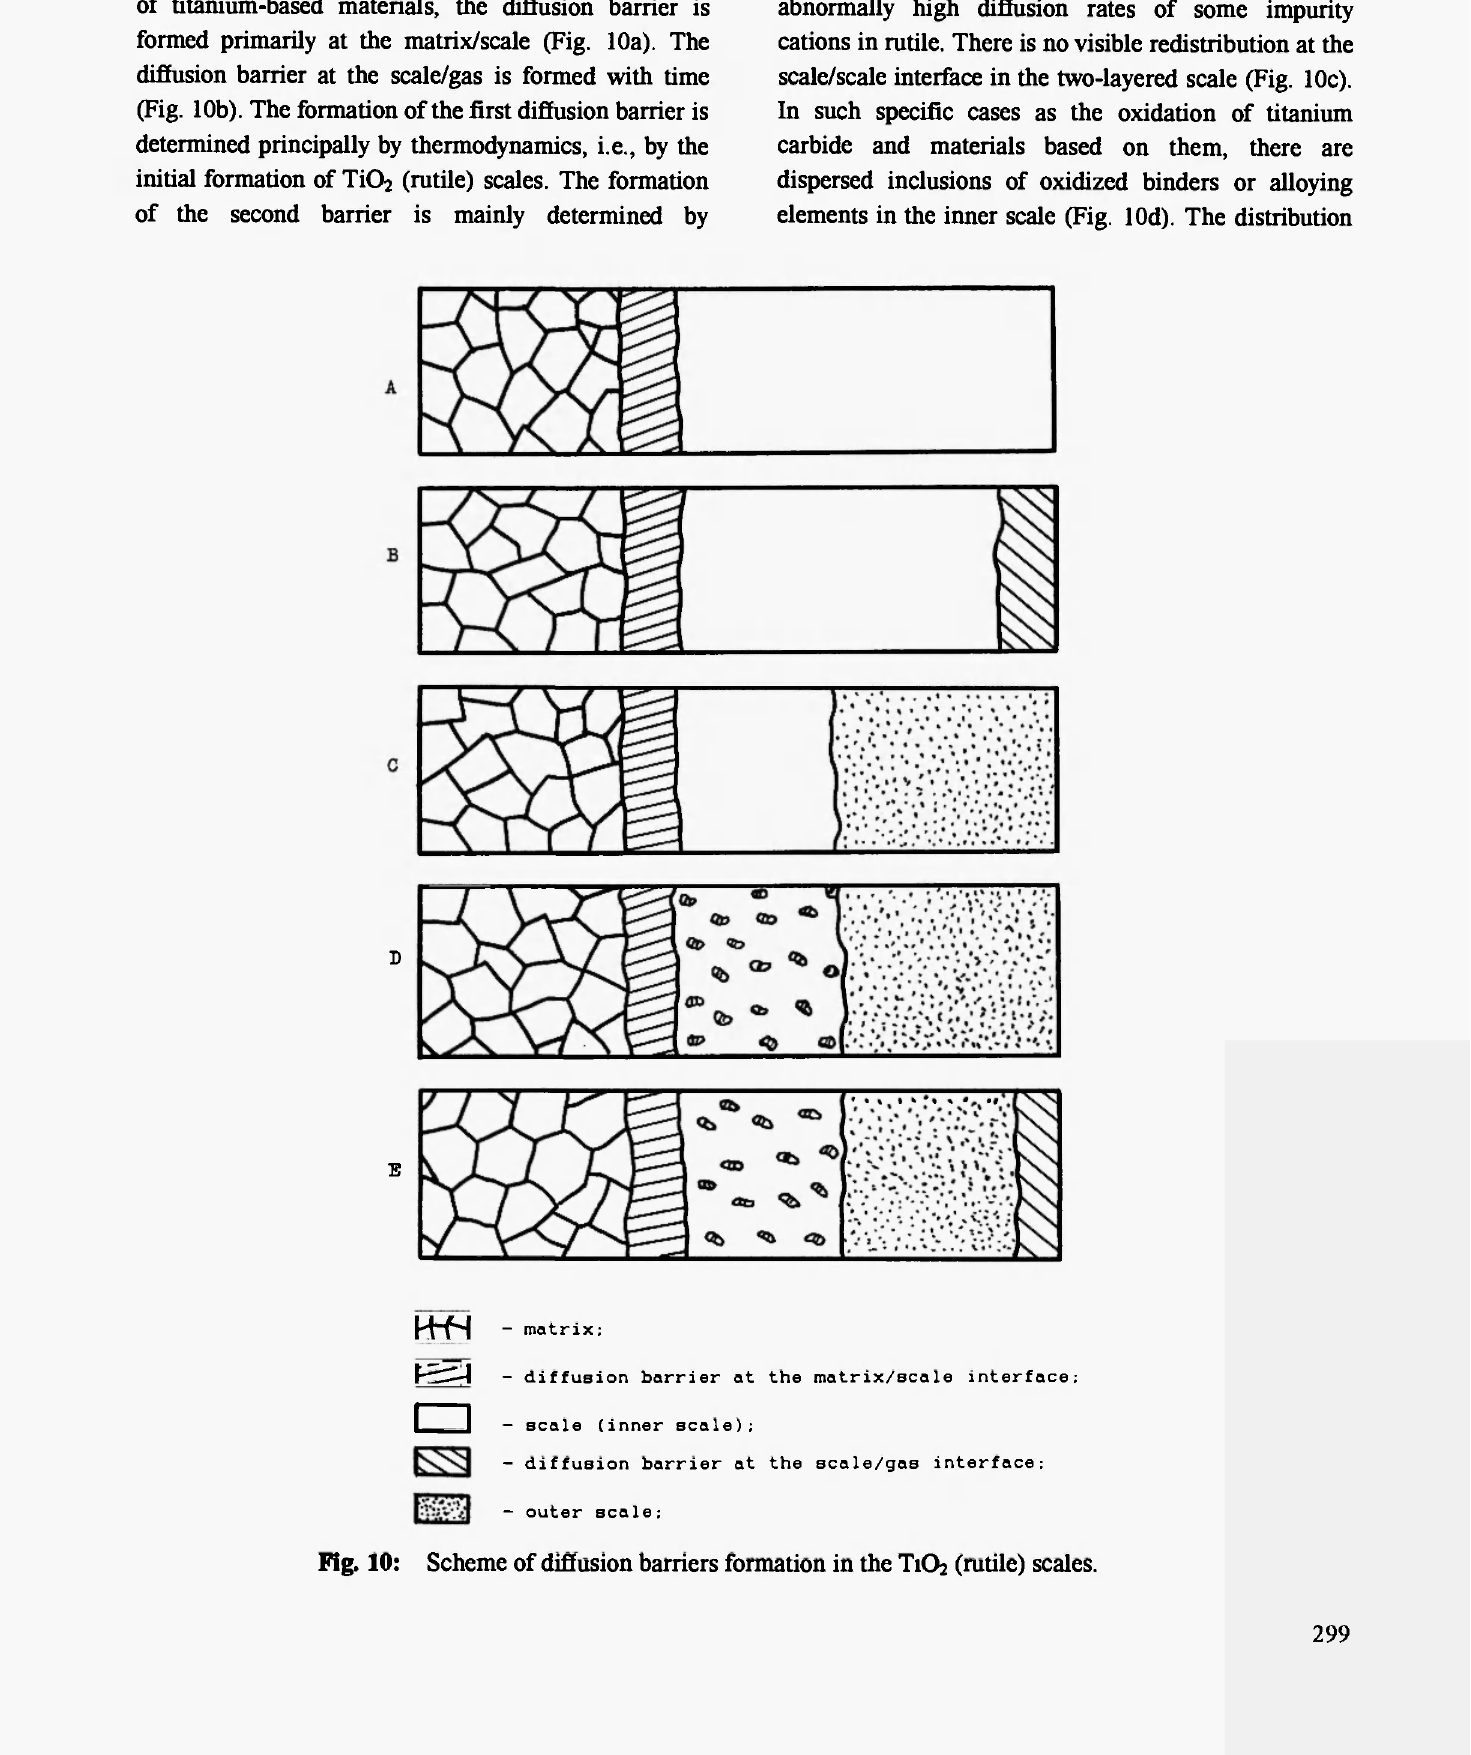
Fig. 10: Scheme of diffusion barriers formation in the T1O2 (rutile)